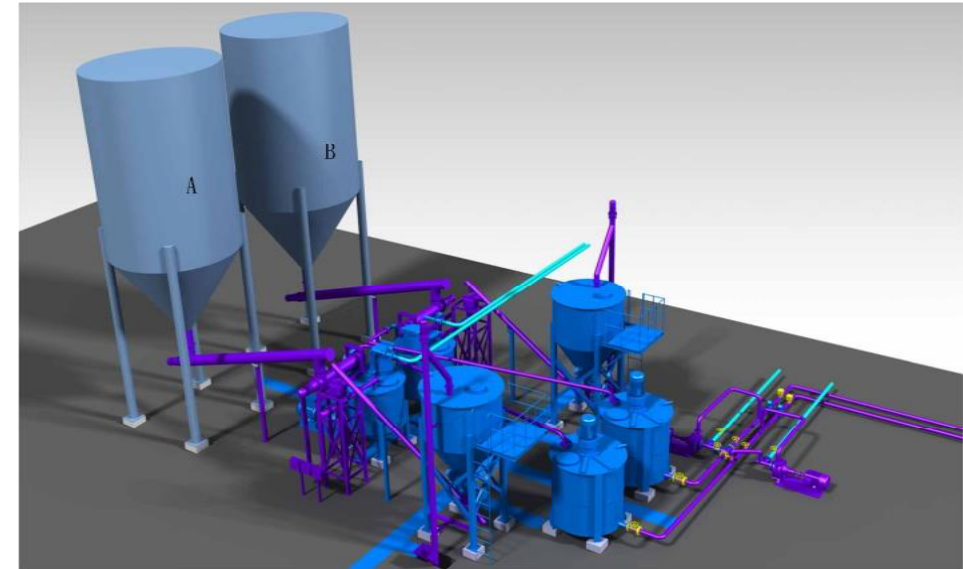
Figure 21. Automatic pulping system of the high-water material.